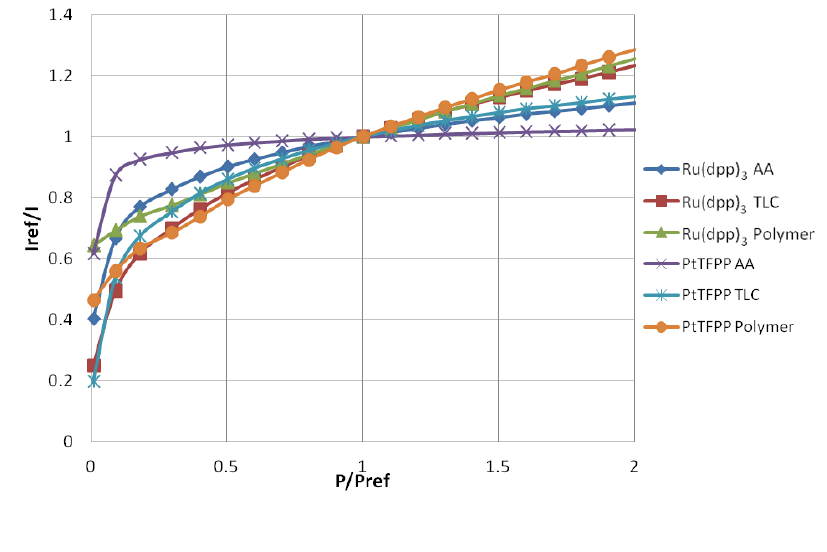
Table 2. Pressure